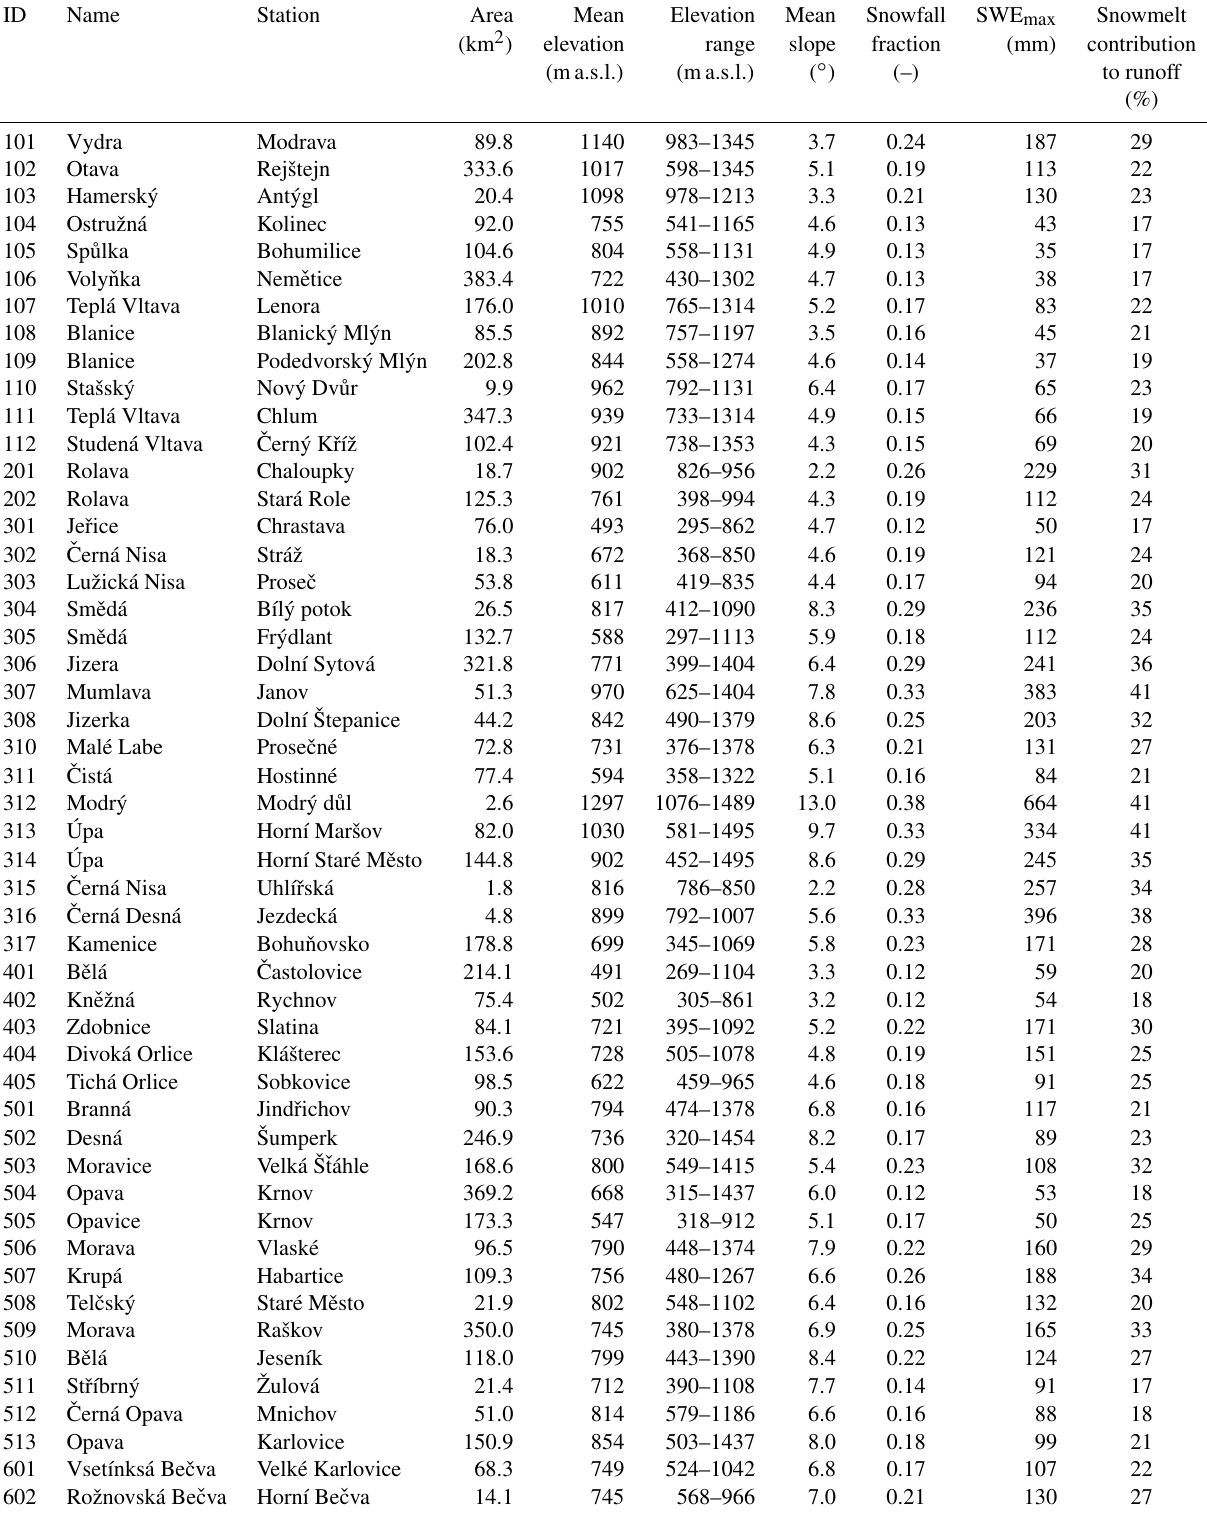
Table 1. Selected characteristics of the study catchments. Catchments IDs are given in the following way: 100 – Bohemian Forest (BF), 200 – Ore Mountains (OM), 300 – Western Sudetes (WS), 400 – Central Sudetes (CS), 500 – Eastern Sudetes (ES) and 600 – Western Carpathians (WC). Snowfall fraction, SWE max and snowmelt contribution to runoff represent catchments means (1980–2014) resulting from model